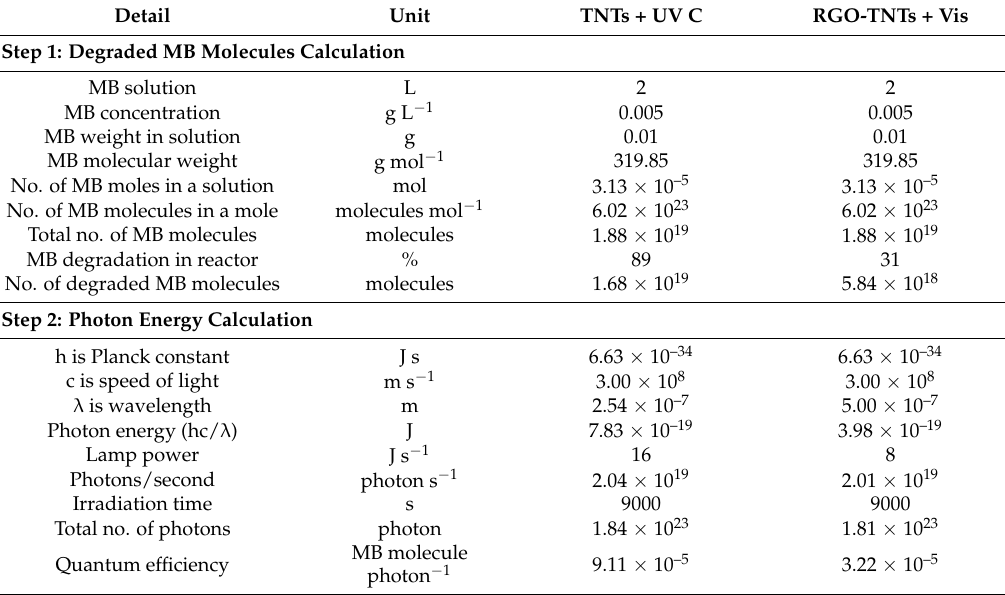
Table 3. Calculation of quantum efficiency of the photocatalytic reactor using UV C and visible lamp. Detail